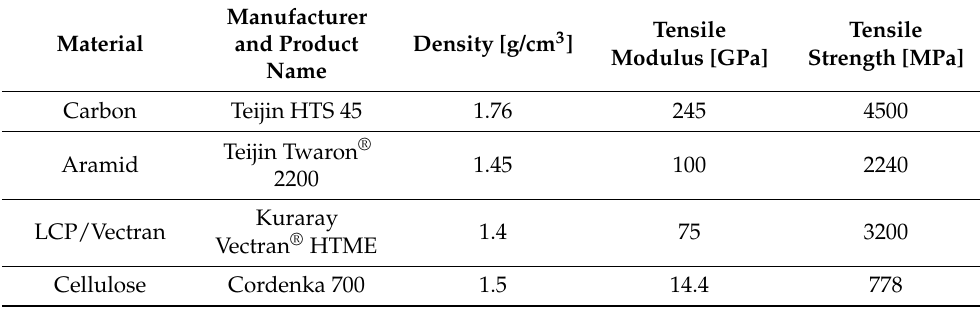
Table 1. Properties of the fibers used.